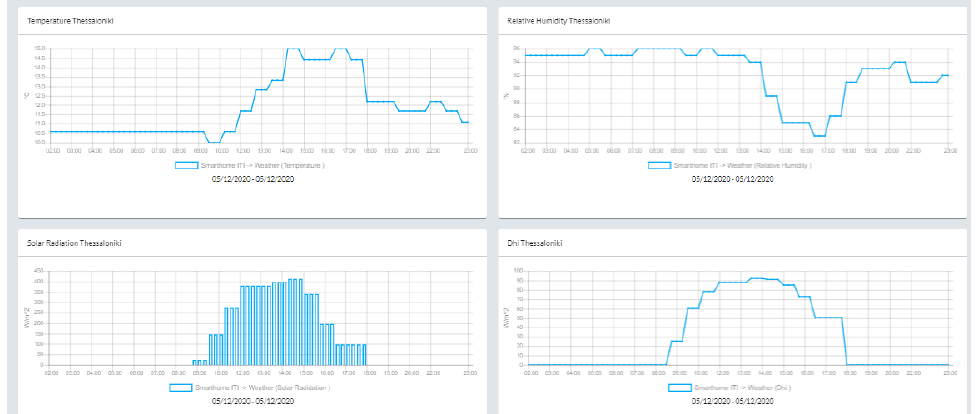
Figure 11. Weather tool monitoring and real-time visualization to the